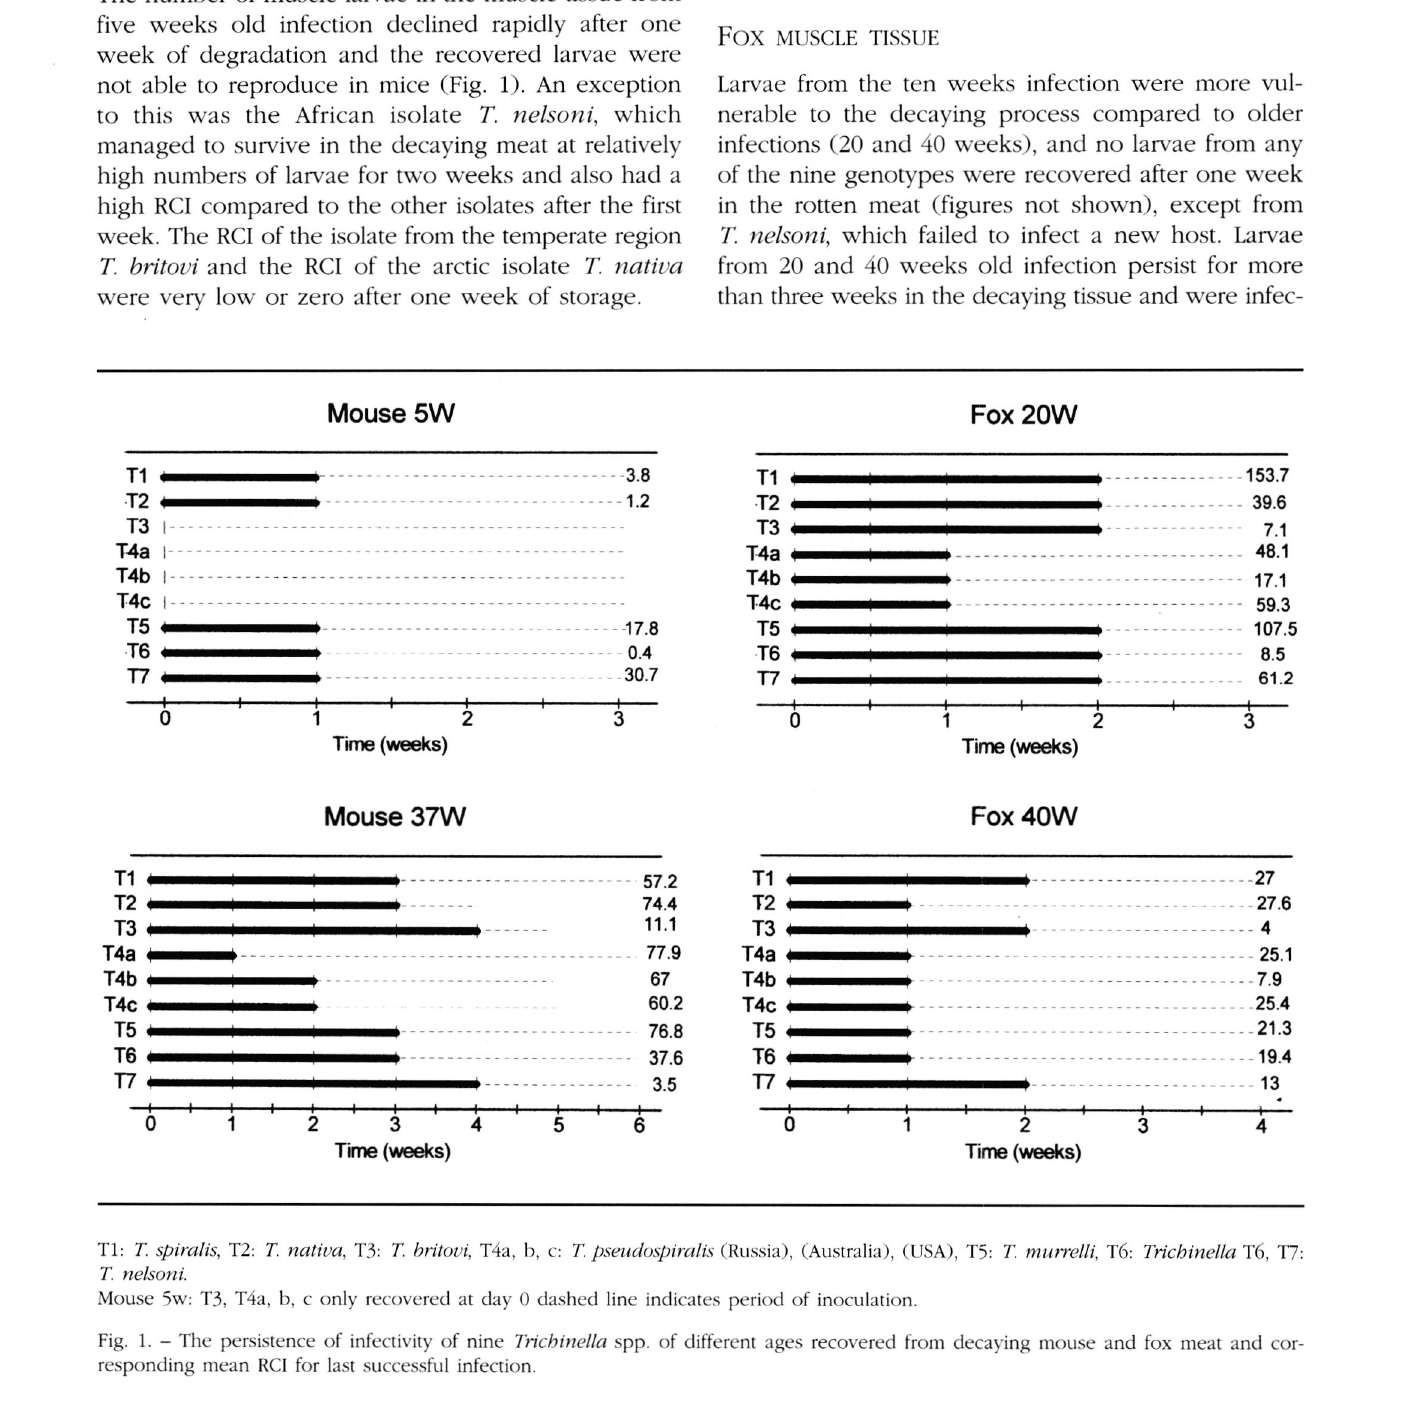
Fig. 1. - The persistence of infectivity of nine Trichinella spp. of different ages recovered from decaying mouse and fox meat and cor responding mean RCI for last successful infection.